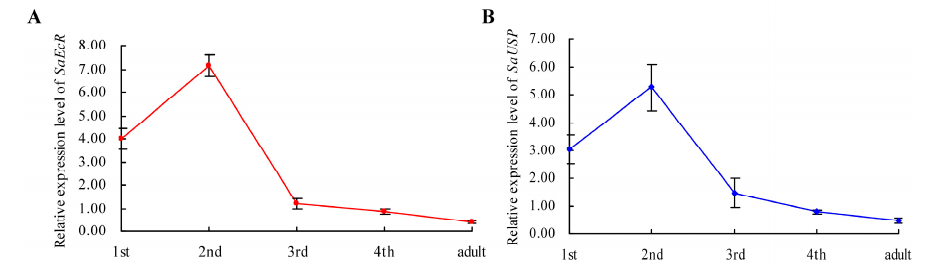
Figure 1. Phylogenetic trees of the ecdysone receptor (EcR) and ultraspiracle protein (USP) in grain aphid and other insect species. Insect phylogenetic trees showed the phylogenetic relationships of the species addressed in this study. ( A ) Evolutionary relationships between the EcR of grain aphid and those of other insects; ( B ) Evolutionary relationships between the USP of grain aphid and those of other insects. The joint enrooted tree was generated using MEGA 6.0 by the minimum evolution method. Bootstrap values were indicated at each branch.